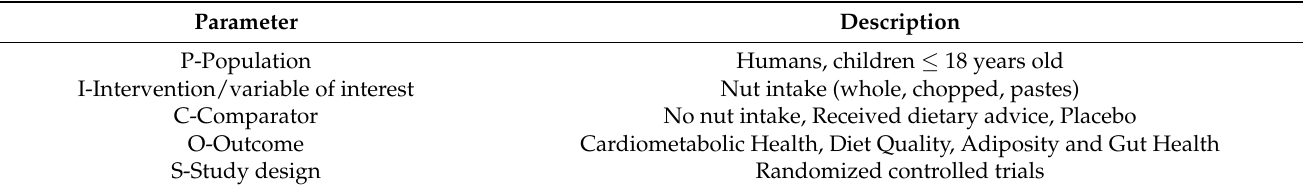
Table 1. Description of the PICOS criteria used to define the research